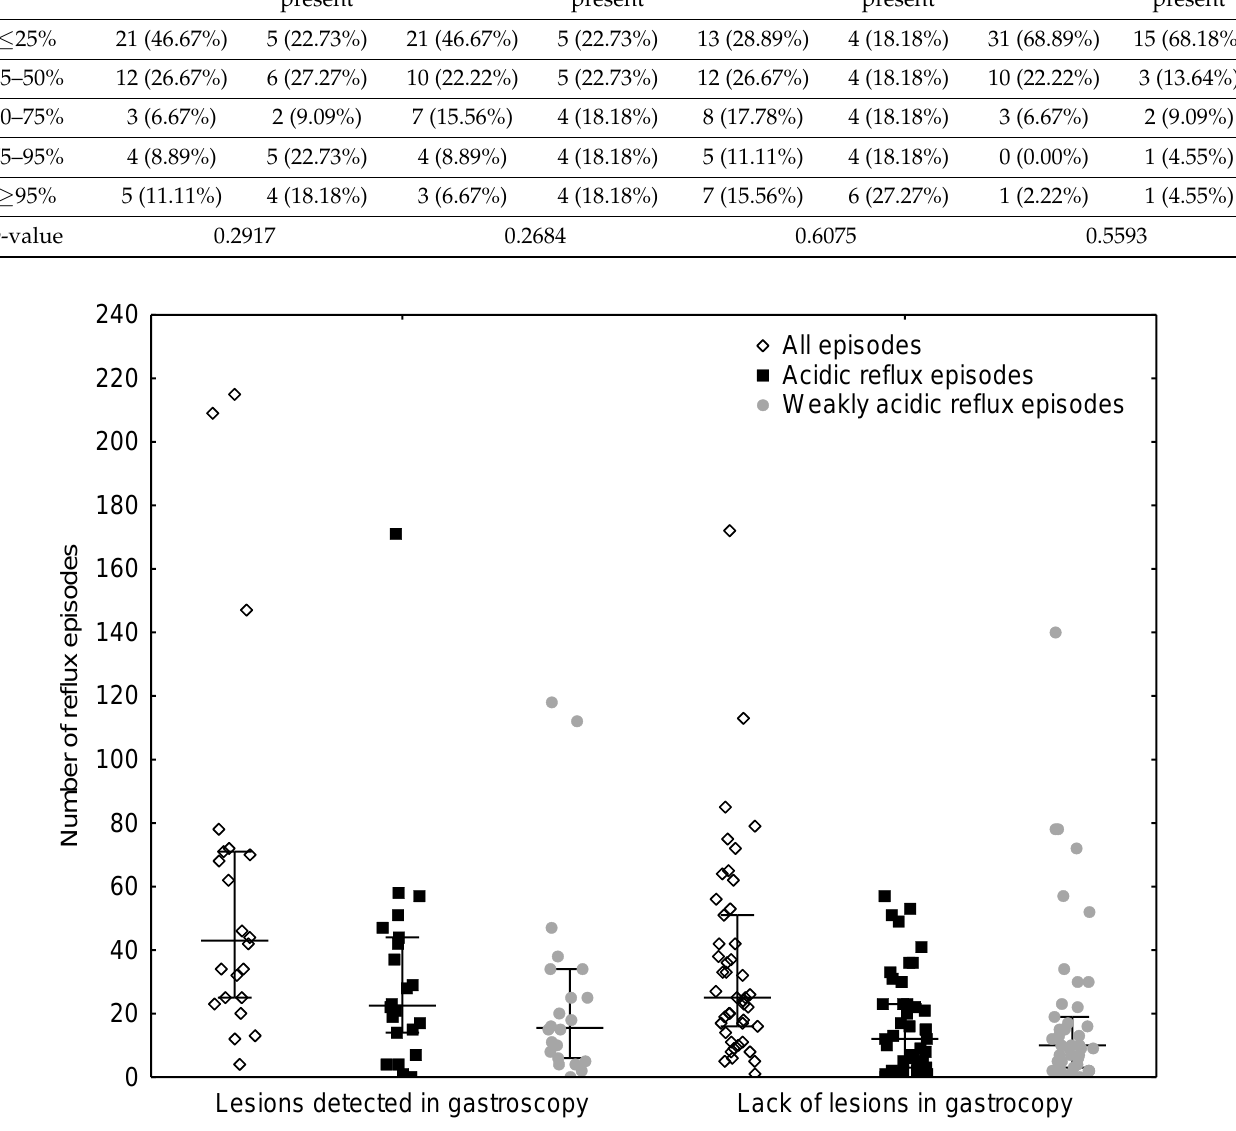
Figure 1. Number of reflux episodes in children with and without lesions in gastroscopy.